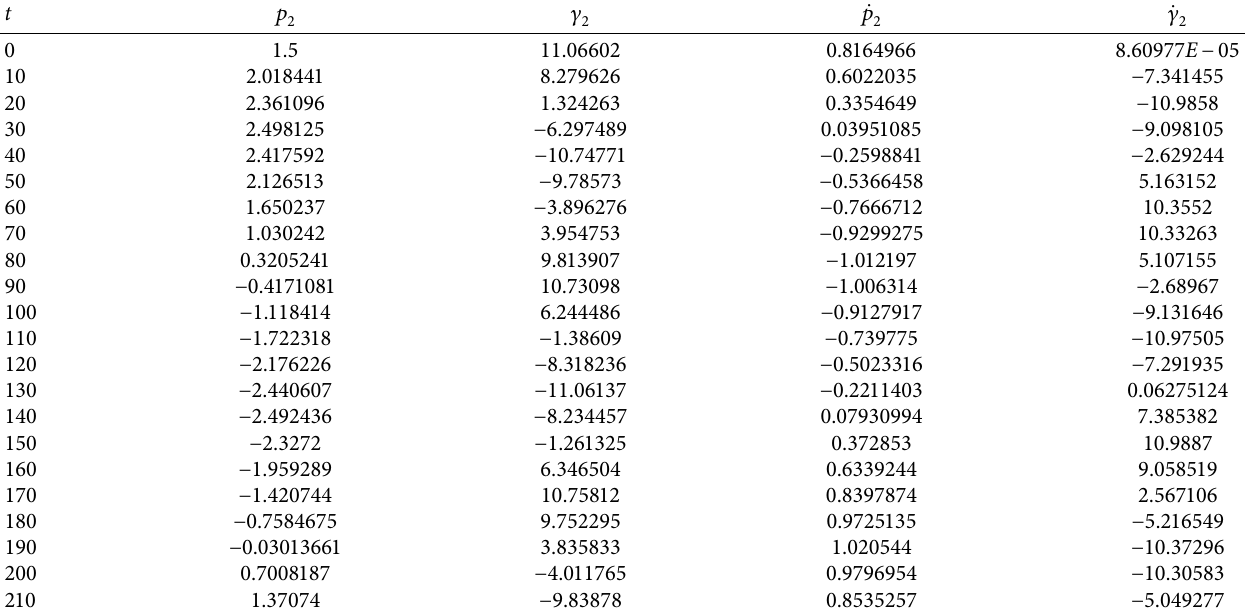
, c , and their 2 2